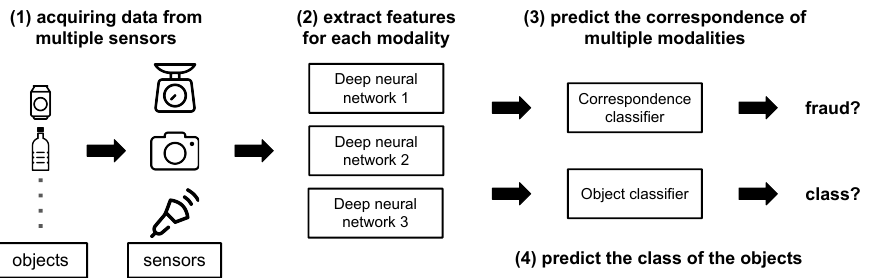
Figure 6. Block diagram of the multi-modal system with correspondence